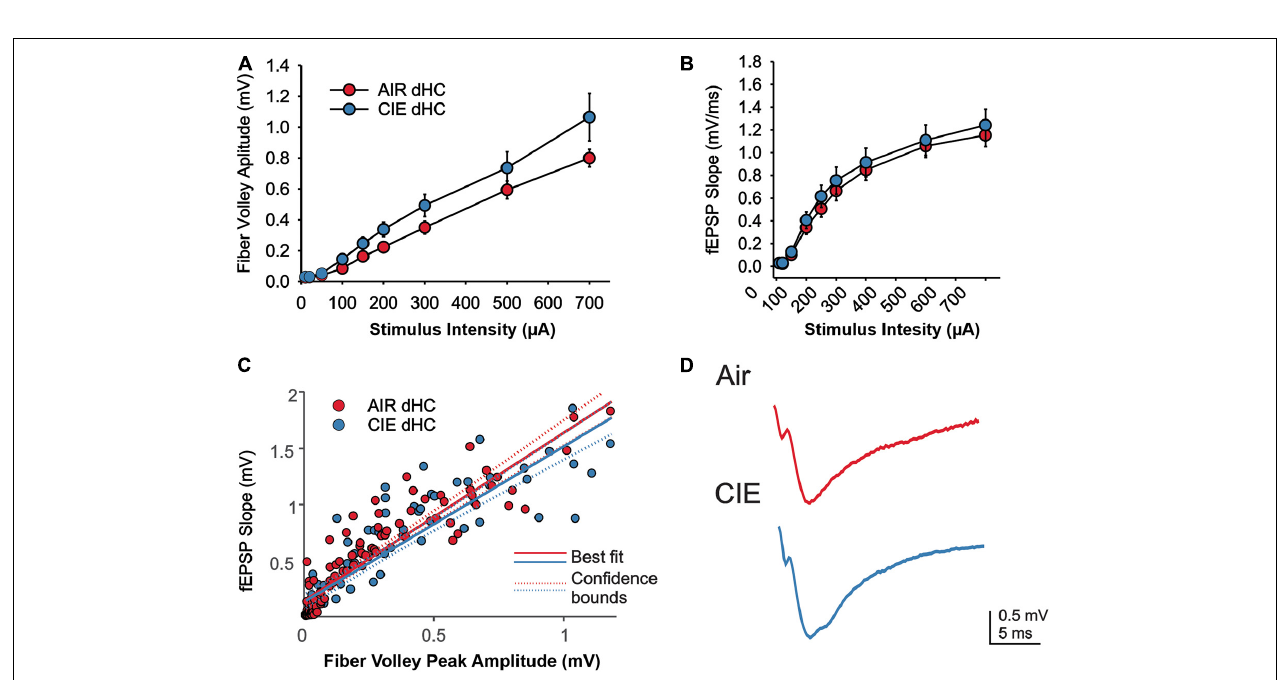
FIGURE 6 | Excitatory neurotransmission in the dHC was not impacted by CIE treatment. We found no effect of CIE on the stimulus-dependent (A) fV amplitude and (B) fEPSP slope, or (C) the relative balance between dHC fV amplitude and fEPSP. (D) Representative example traces of fEPSPs acquired from slices of an Air (upper trace) and CIE-treated (lower trace) rat. All data are expressed as the mean ±